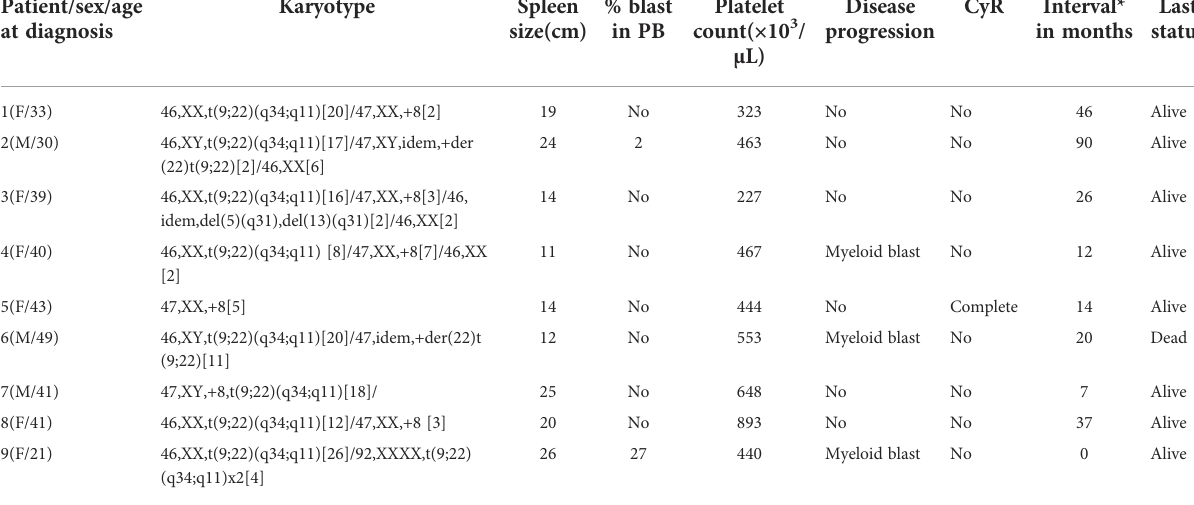
*Interval (month) between CML diagnosis and emergence of ACAs. PB, peripheral blood; CyR, cytogenetic response. Group 1 (Trisomy 8 and double Philadelphia chromosome).